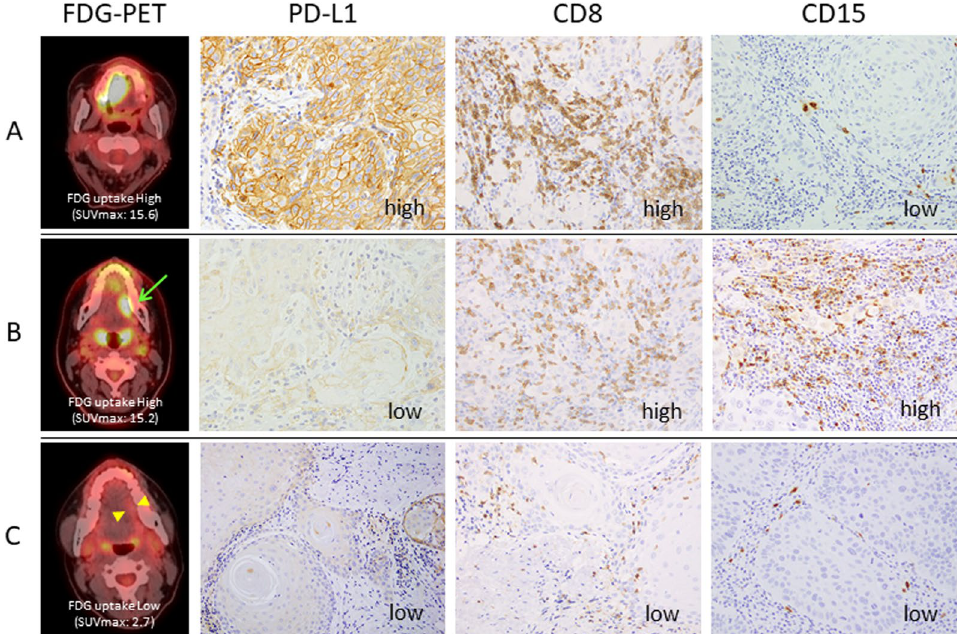
Fig. 1 Fluoro- d -glucose–positron emission tomography (FDG PET-CT) and immunohistochemical analysis of programmed death ligand-1 (PD-L1) expression, CD8 + cells, and CD15 + cells. Row A (a 76-year-old female patient with tongue cancer, cT4a), representing group I or group A (Fig. 3A), reveals high FDG uptake, high PD-L1 expression, high CD8 + cell counts, and low CD15 + cell counts. Row B (a 23-year-old female patient with tongue cancer, cT2), representing group IV or group D, presents high FDG uptake, low PD-L1 expression, and high CD8 + and CD15 + cell counts. Row C (a 32-year-old female patient with tongue cancer, cT1), belonging to group II or group C, reveals low FDG uptake, low PD-L1 expression, and low CD8 + and CD15 + cell